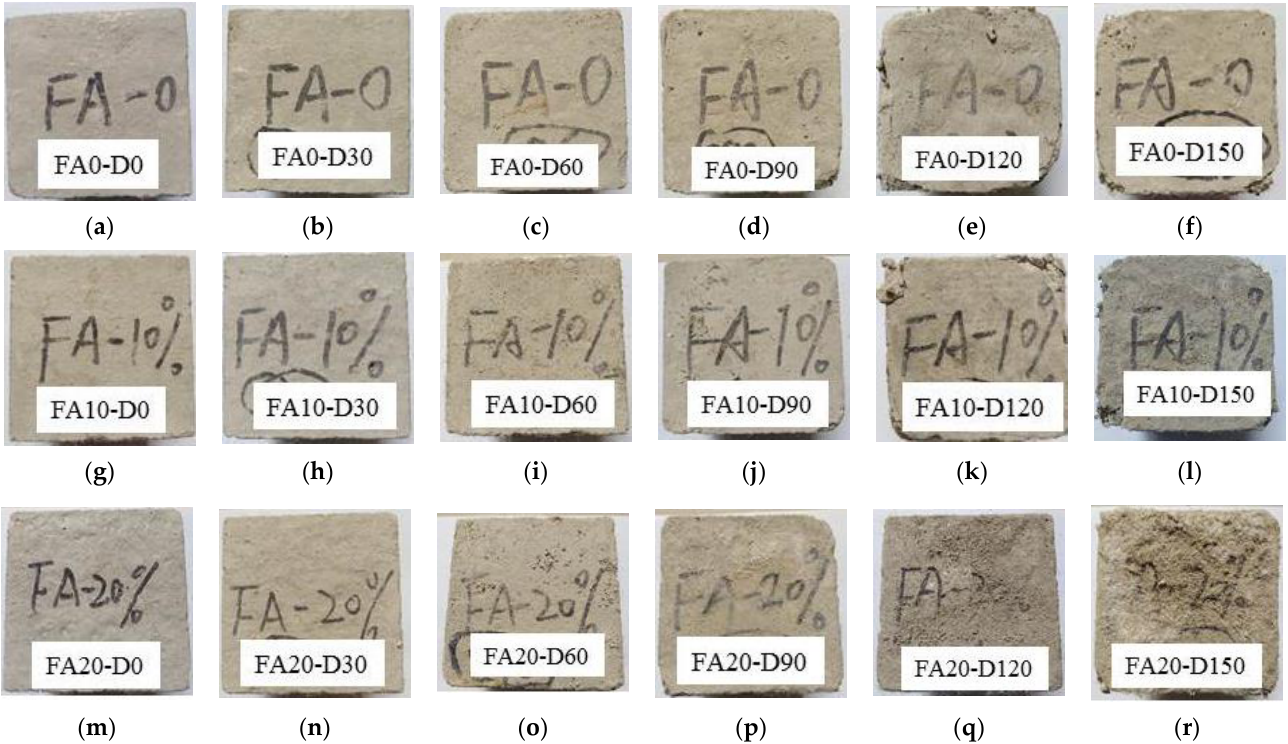
Figure 6. Deformation appearances of concrete samples subjected to sulfate attack. ( a ) FA0-D0; ( b ) FA0-D30; ( c ) FA0-D60; ( d ) FA0-D90; ( e ) FA0-D120; ( f ) FA0-D150; ( g ) FA10-D0; ( h ) FA10-D30; ( i ) FA10-D60; ( j ) FA10-D90; ( k ) FA10-D120; ( l ) FA10-D150; ( m ) FA20-D0; ( n ) FA20-D30; ( o ) FA20-D60; ( p ) FA20-D90; ( q ) FA20-D120; and ( r ) FA20-D150.